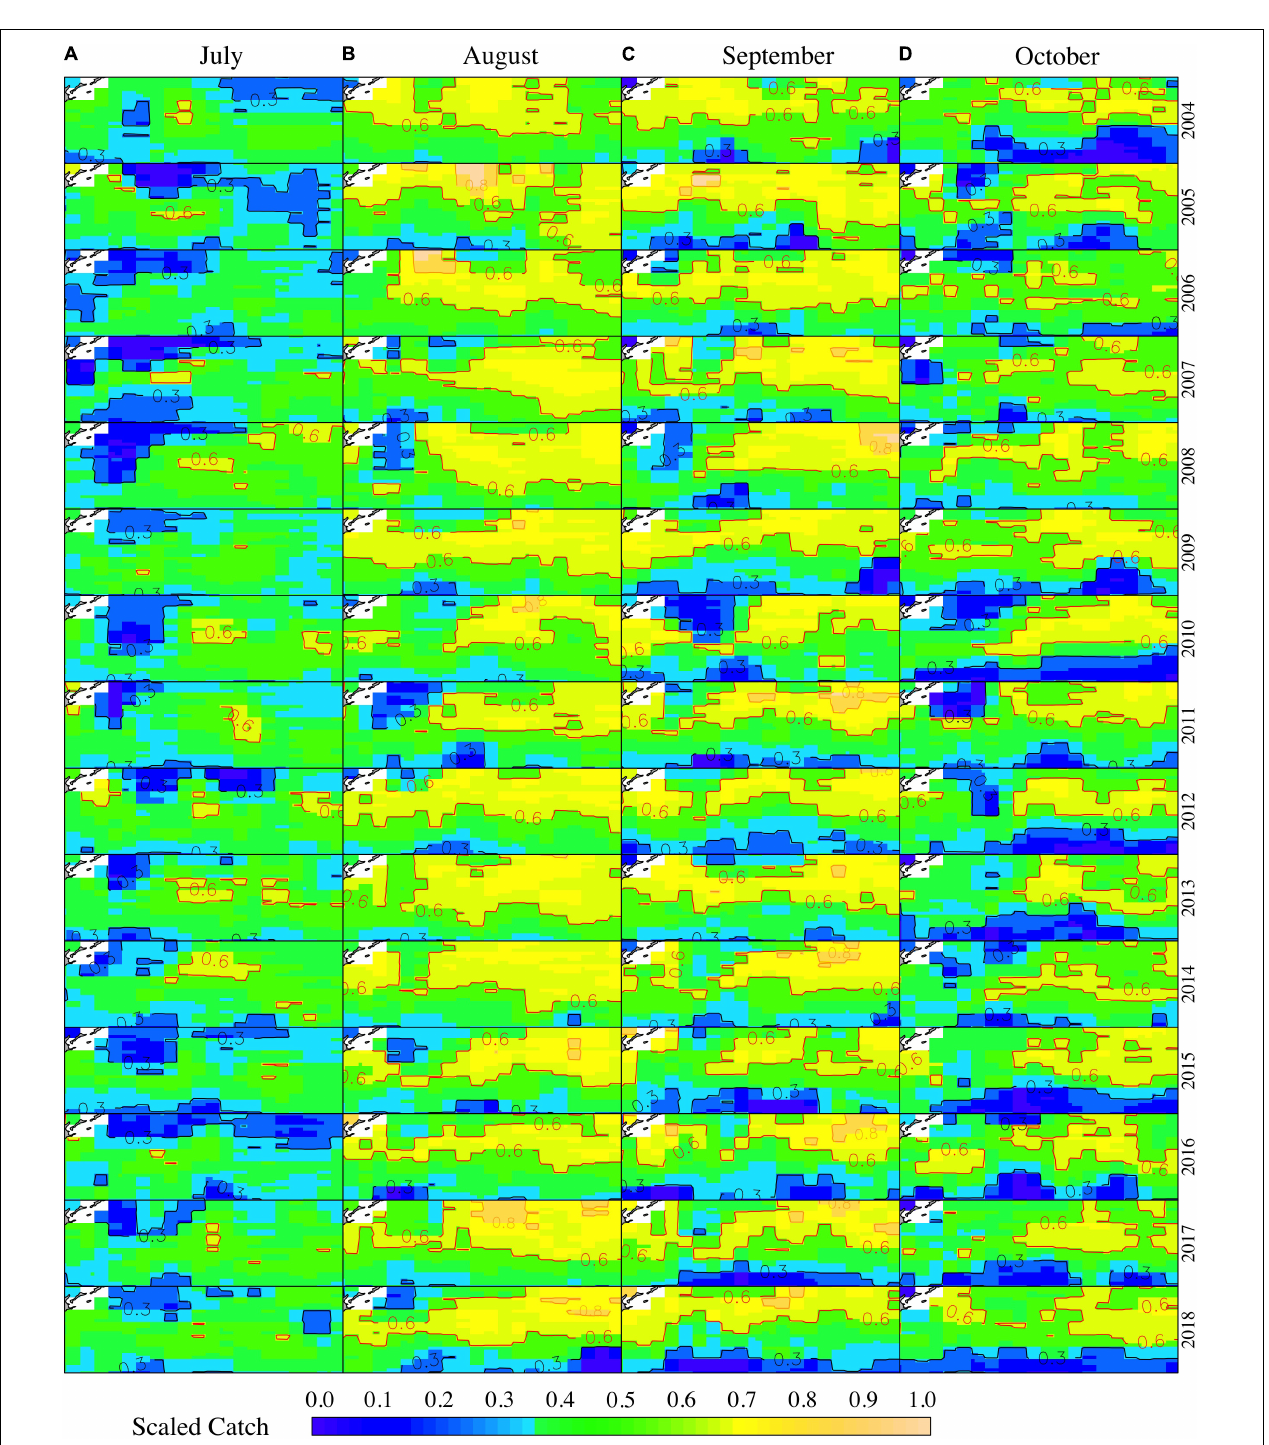
FIGURE 5 | The distribution of habitat area for O. bartramii for the months of July (A) , August (B) , September (C) , and October (D) from 2005 to 2018. The spatial range for each subplot is 38 ◦ –45 ◦ N and 145 ◦ –165 ◦ E.